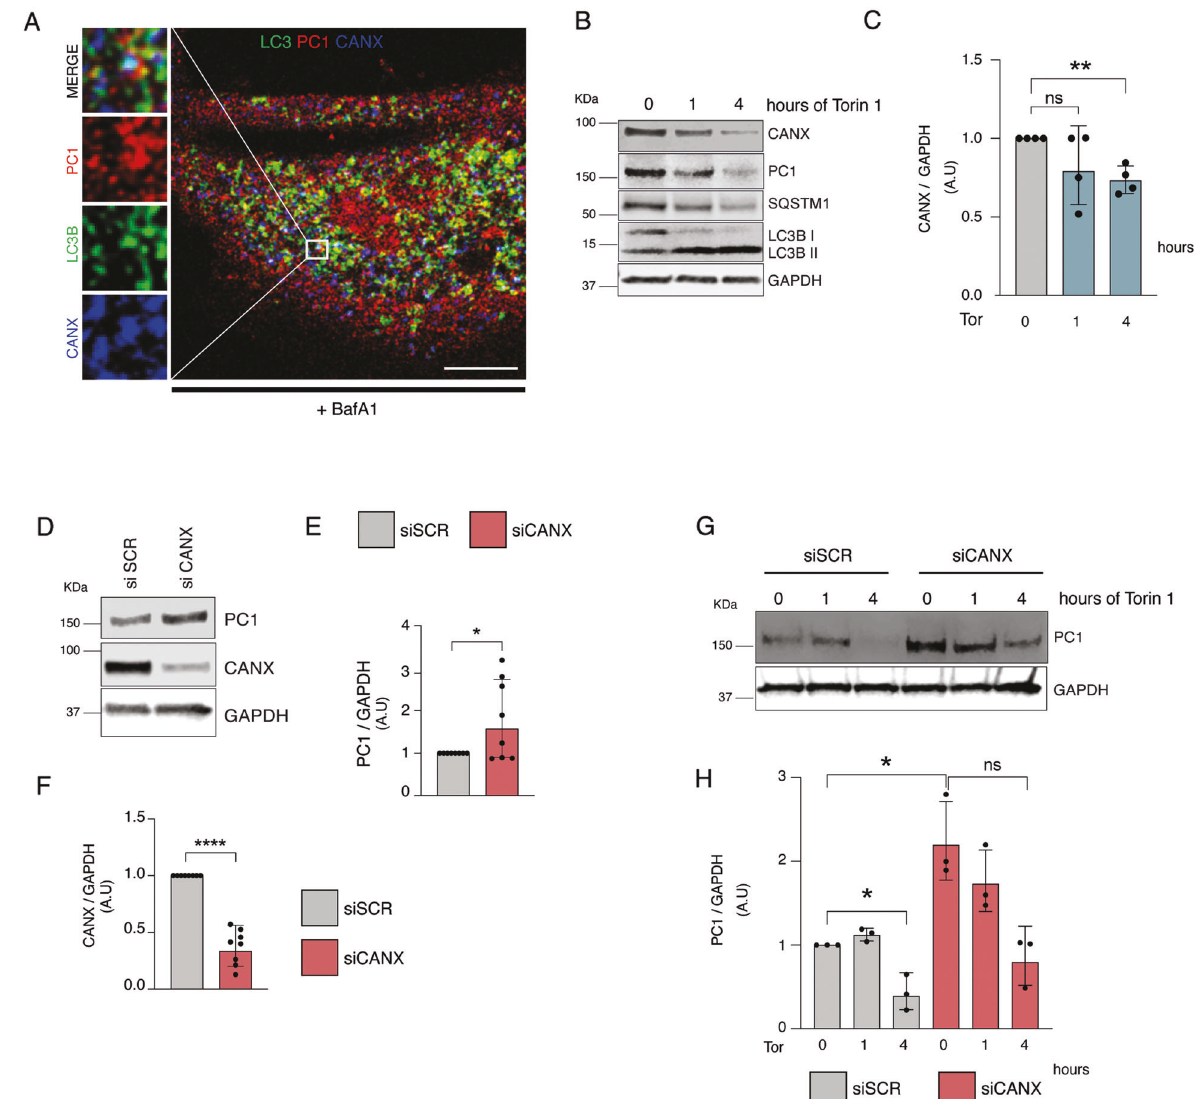
magni fi cation and single color channels of the boxed area. Scale bars = 10 μ m. B Western blot analysis of CANX, PC1, SQSTM1/p62, and LC3B in control and Torin 1 (Tor)-treated cells for 1 and 4 h. GAPDH was used as a loading control. C Quanti fi cation of CANX western blot data. Data are representative of four independent experiments made with cells from four different human donors. ** p < 0.01, *** p < 0.001, unpaired t - test. D Western blot analysis of PC1 and CANX, in siSCR and siCANX cells. GAPDH was used as a loading control. Quanti fi cation of the normalized PC1 ( E ) and CANX ( F ) proteins levels. Data are representative of eight independent experiments made with cells from three different human donors. * p < 0.05, **** p < 0.0001, unpaired t -test. G Western blot analysis of PC1 and SQSTM1/p62, siSCR, and siCANX cells treated with Torin 1 for 1 and 4 h. GAPDH was used as a loading control. H Quanti fi cation of the normalized PC1 protein levels. Data are representative of three independent experiments made with cells from three different human donors. * p < 0.05, unpaired t